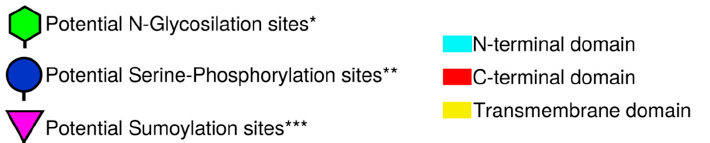
Figure 1. Domain structure and potential post-translational modification sites of human RPRM and RPRML proteins. Schematic representation shows the RPRM and RPRML putative N -glycosylation (green hexagons), serine-phosphorylation (blue circle) and sumoylation (purple triangle) sites. The N-terminal, transmembrane and C-terminal domains are represented by colored boxes (turquoise, yellow, and red, respectively). An * (asterisk) indicates positions which have a single, fully conserved residue. A: (colon) indicates conservation between groups of strongly similar properties—scoring >0.5 in the Gonnet PAM 250 matrix. A. (period) indicates conservation between groups of weakly similar properties—scoring 0.5 in the Gonnet PAM 250 matrix. Post-translational modification sites were predicted using *NetNGlyc (http://www.cbs.dtu.dk/services/NetNGlyc/),